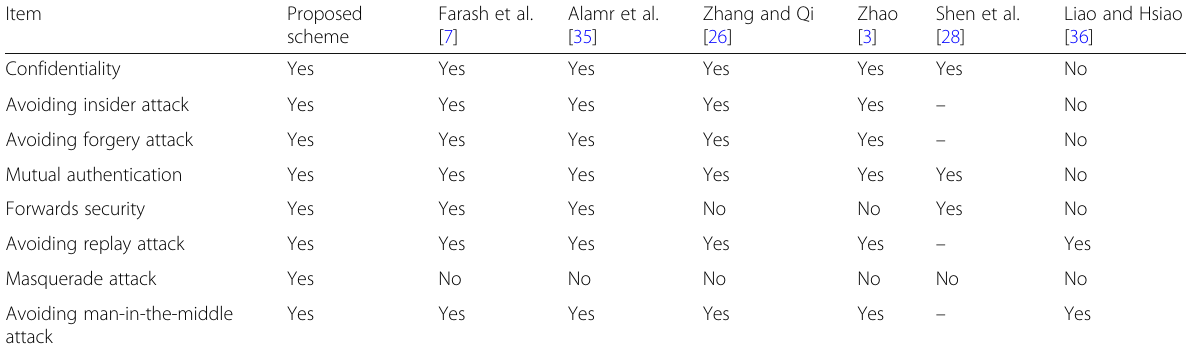
Table 2 Security comparison among related